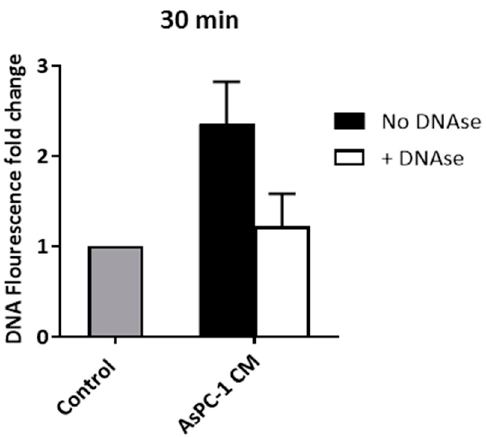
Figure A1. The addition of DNAse I (60 U/mL) abolished extracellular DNA fluorescence to unstimulated control, confirming the specificity of Sytox Green to extracellular DNA (exDNA). Control: unstimulated neutrophils. Data expressed as mean ± SEM from n = 3. Int. J. Mol. Sci. 2017 , 18 , 487